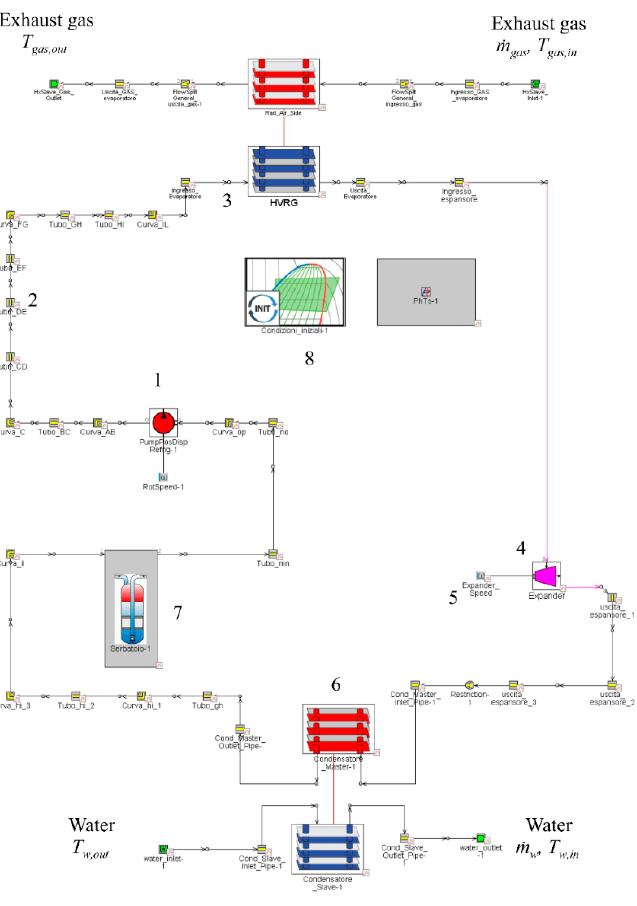
Figure 5. Diagram of the ORC-based power plant model.